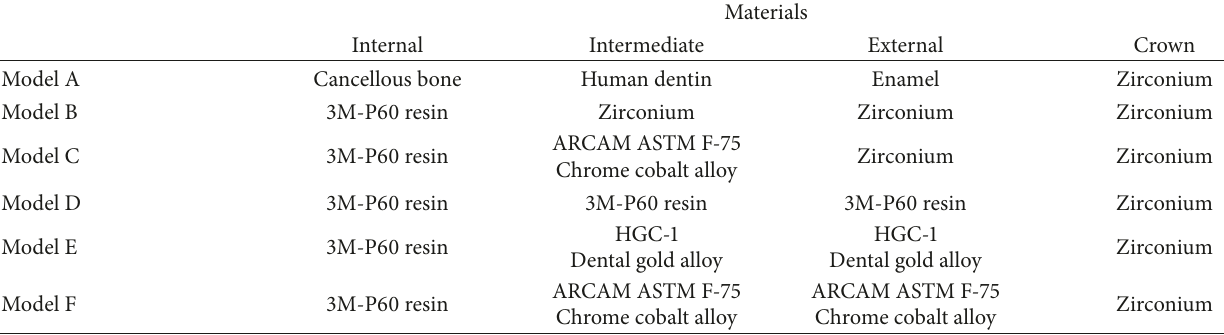
Table 2: Features of the cases presented on each material and layer.